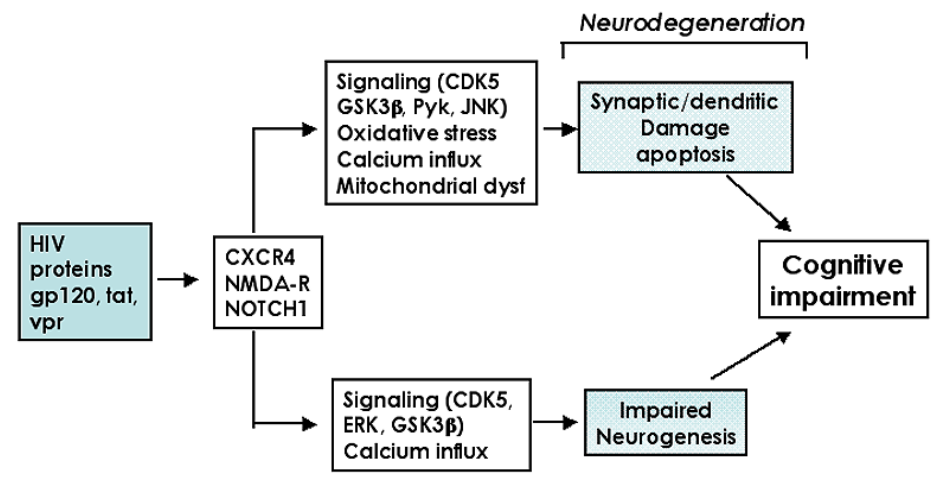
Figure 1. Mechanisms of HIV protein-induced neuronal damage. HIV protein-mediated activation of cell surface receptors (CXCR4, NMDA-R, Notch1) leads to alterations in signaling pathways such as GSK3  and CDK5. Under physiological conditions, these pathways modulate critical substrates involved in synaptic plasticity and neurogenesis, and dysregulation of these signaling cascades could result in synapto-dendritic damage and impaired